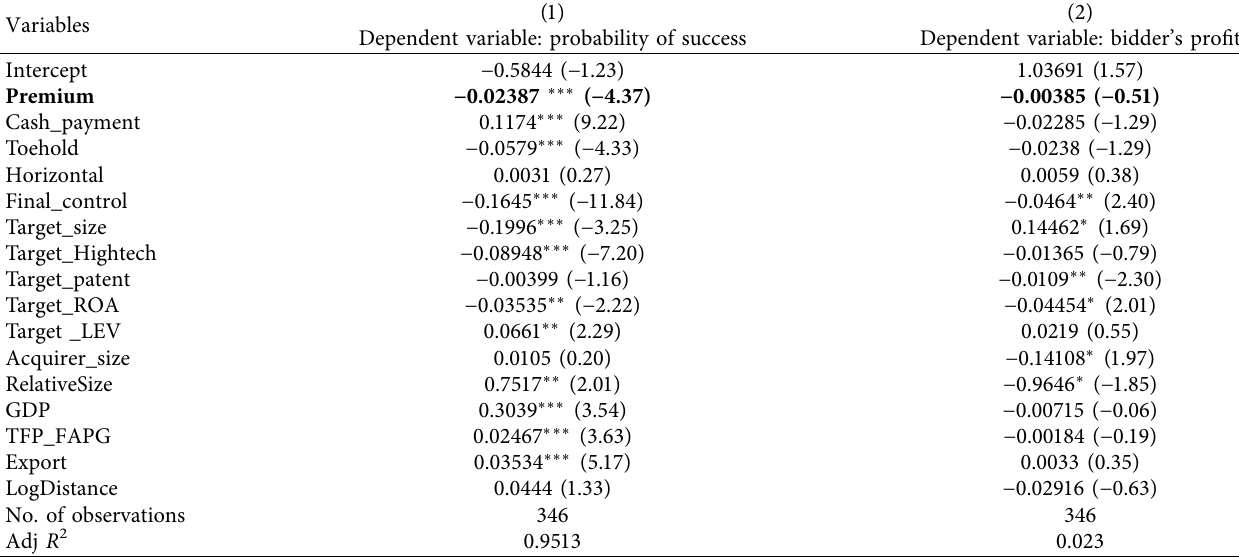
Table 6: SUR regression results of estimating the probability of acquisition success and the bidder’s